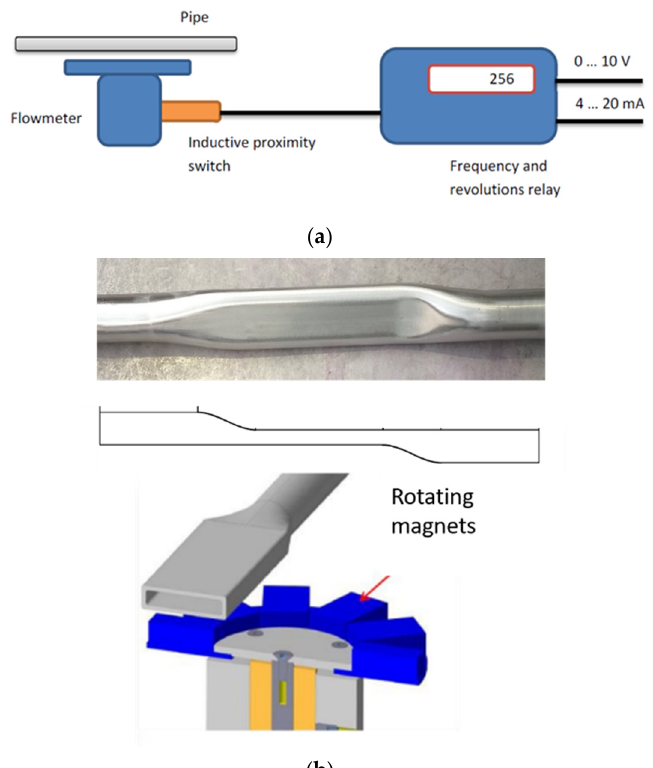
Figure 4. Schematic description of the flow meter ( a ). Custom-made pipe in proximity to the flow meter ( b ).